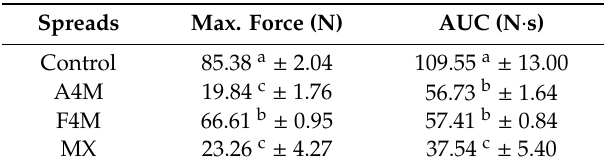
AUC: Area under the curve. abc Values with the same letter for each parameter are not statistically different ( p < 0.05).